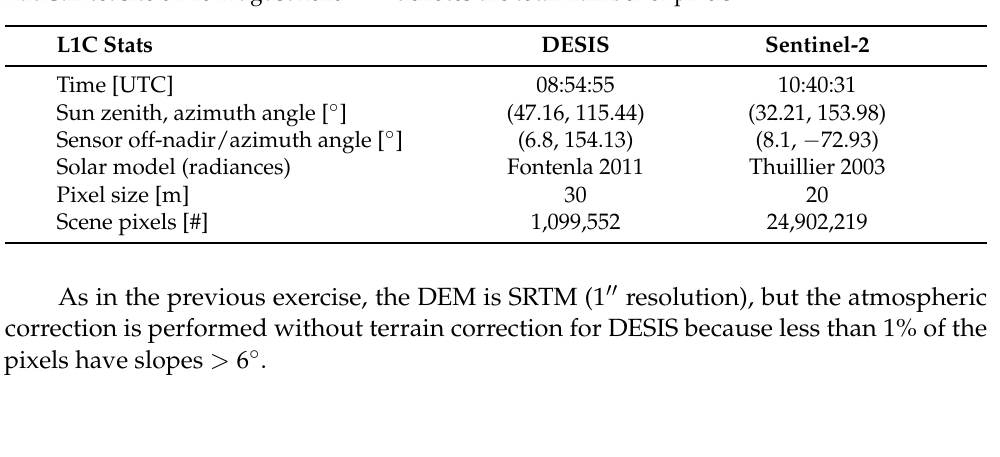
Table 2. Summary of the acquisition conditions of the DESIS and Sentinel-2 overpass over La Crau RadCalNet site on 15 August 2020. “#” denotes the total number of